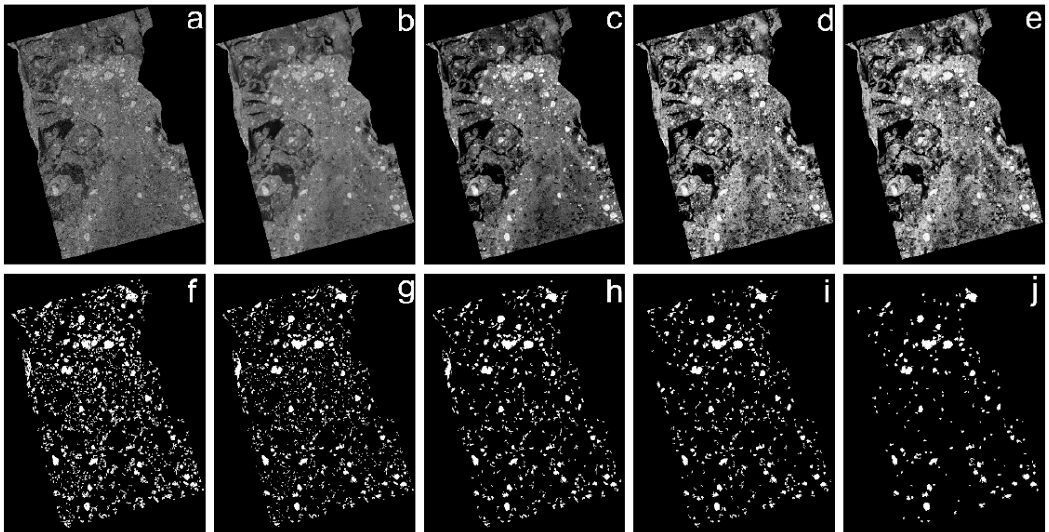
Figure 6. Steps of identifying MYI in SAR image (the example is from image No.4 in the classification columns in Table 1. ( a ) original σ o image, ( b ) image of GLCM texture mean parameter with (W = 11, D = 1, K = 32), ( c ) linear stretch, ( d ) adaptive histogram equalization, ( e ) opening by reconstruction, ( f ) extended-maxima operator, ( g ) morphological image processing. ( h ) removal of small regions, ( i ) using the eccentricity of shape feature, ( j ) using the extent and area of shape feature.